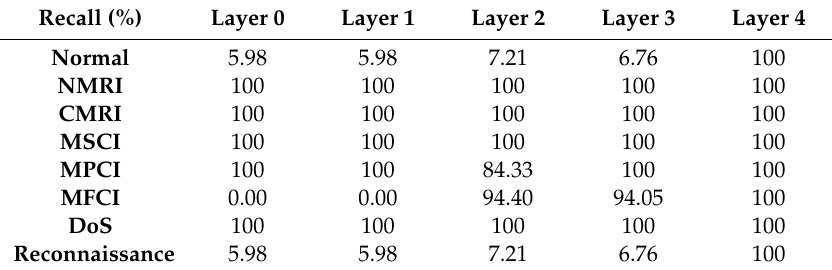
Table 4. Recall of the Clustering Results for Each Class In Each Hidden